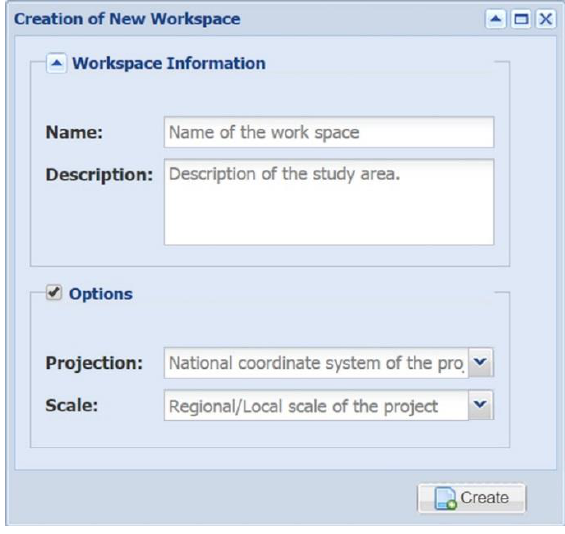
Figure 9. Creation of a new study site